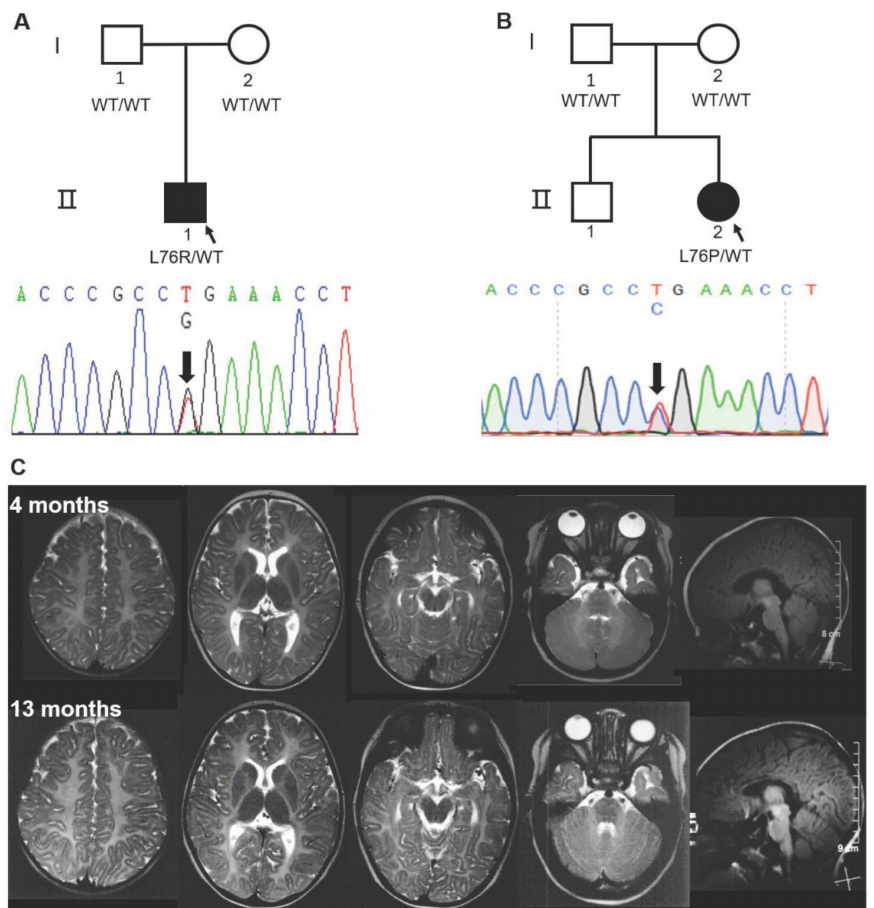
Figure 1. Sanger sequencing of two HLD pedigrees and representative MRI of Patient 2 with the TMEM163 -L76P mutation. ( A , B ) De novo heterozygous c.227T>G p.(L76R) and c.227T>C p.(L76P) in TMEM163 was identified in two probands, respectively. I, parents; II, progeny. ( C ) Diffuse hypo- intense signal on T2-weighted images at 4 months and 13 months indicated hypomyelination in cerebral white matter ( C ). WT, wild